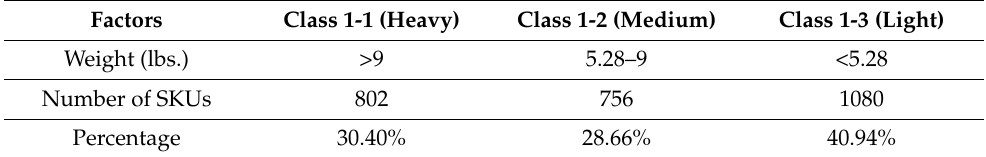
Table 2. Weight-based classes for Scenario 1.